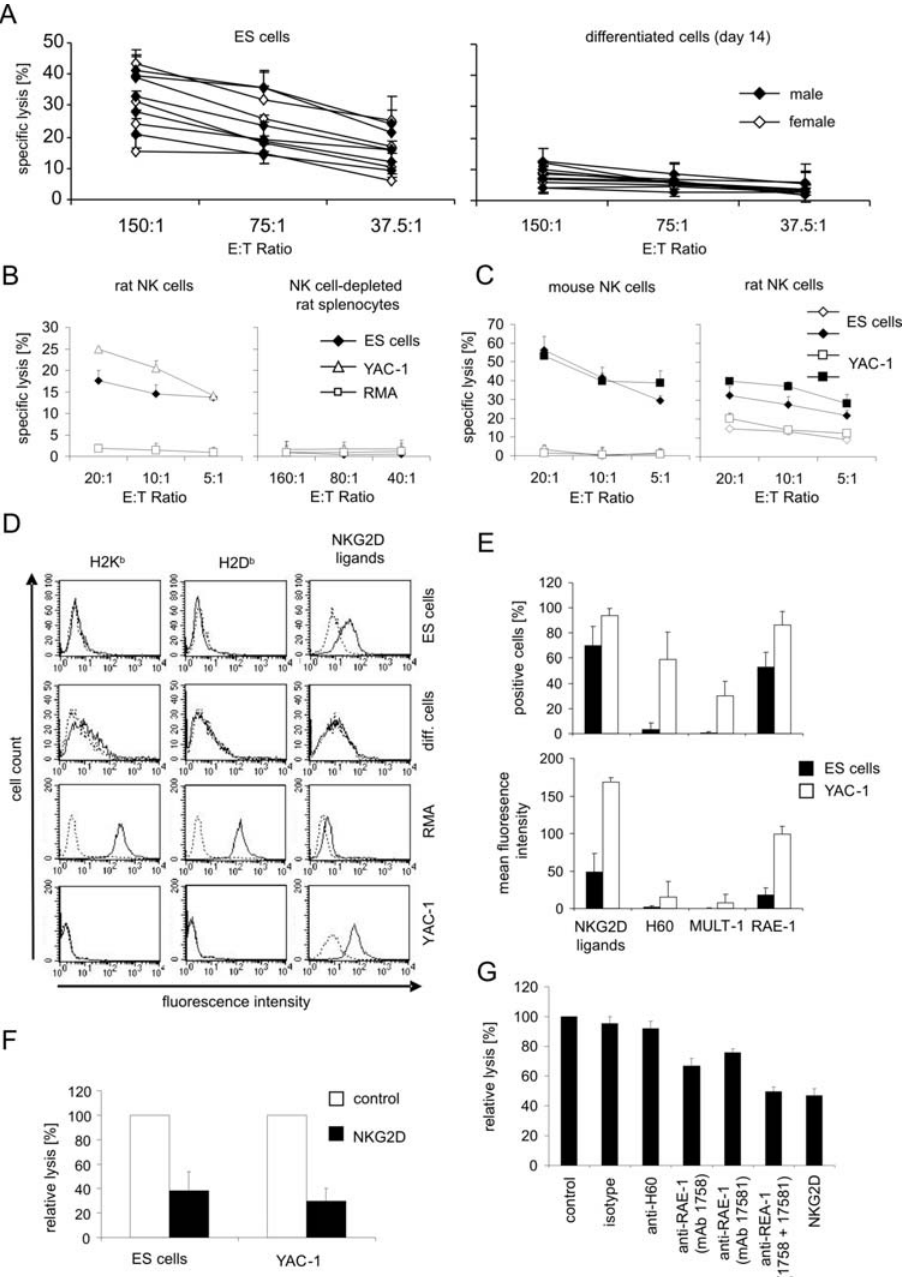
Figure 6. Lysis of ES and invitro differentiated cells by NK cells derived from naı¨ve LOU/c rats and expression analysis of MHC class I molecules and NKG2D ligands. (A) Mean of specific lysis and standard deviation (SD) of triplicates of ES or in vitro differentiated cells at three effector:target (E:T) ratios. Effector cells were lymphocytes obtained from spleens of 10 individual LOU/c rats by density gradient centrifugation on Biocoll. Results obtained with lymphocytes from female rats are indicated by open symbols and from male rats by filled symbols. (B) The mean specific lysis and SD of triplicates of ES, YAC-1, and RMA target cells at three effector:target (E:T) ratios by freshly isolated NK cells or NK cell-depleted splenocytes from naı¨ve LOU/c rats are shown. The NK cell enriched fraction contained 86% and the NK cell depleted fraction 3% NKR-P1A-positive cells as determined by flow cytometry. The results are representative for 3 independent experiments. (C) The mean specific lysis and SD of triplicates of ES and YAC-1 cells at three effector:target (E:T) ratios by freshly isolated (open symbols) or 3 days in vitro with 1000 U/ml IL-2 stimulated (closed symbols) mouse and rat NK cells are shown. The NK cell-enriched fractions contained more than 80% NK cells as determined by flow cytometry. The results shown are representative for 3 independent experiments. (D) The expression of MHC class I molecules on ES and differentiated cells was analyzed by flow cytometry using anti-H2K b and anti-H2D b Abs (full lines). The stainings with the isotype control are shown by the dotted lines. RMA cells (H2 b ) served as positive control for these antibodies. NKG2D ligands were stained with a recombinant mouse NKG2D-Fc chimeric protein and a FITC-conjugated goat anti-human IgG antibody as secondary reagent (full lines). Stainings with the secondary reagent only are shown by the dotted lines. YAC-1 cells (H2 a ) served as positive controls for these stainings. The results shown are representative for more than 3 independent experiments. (E) ES and as positive control YAC-1 cells were stained with the NKG2D-Fc chimeric protein and with mAbs specific for the NKG2D ligands H60, MULT- 1, and RAE-1. The mean + SD of the proportion of positive cells and the mean fluorescence intensity + SD determined in 6 independent experiments is shown. (F) The mean inhibition + SD of specific lysis of ES and YAC-1 cells by soluble mouse NKG2D is shown as determined in 3 experiments. The PLoS ONE |